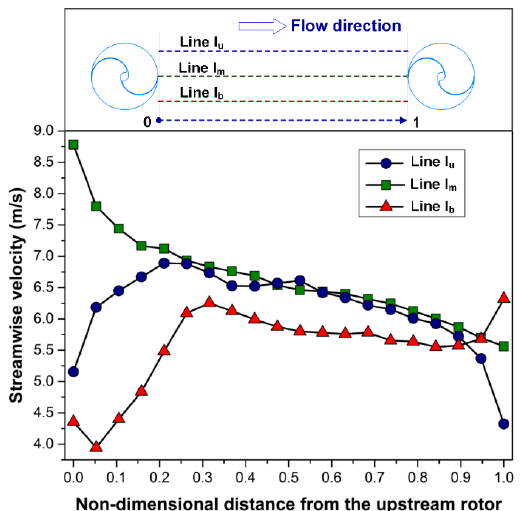
Figure 10. Velocity distributions between the upstream and downstream rotors.